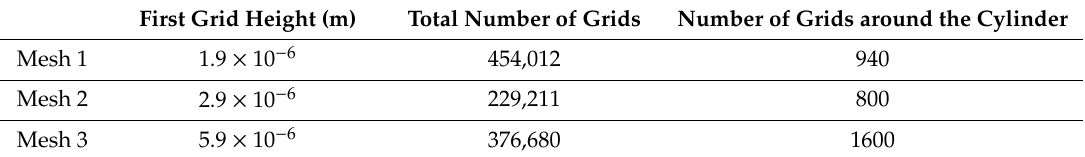
Table 1. Mesh information for grid convergence.